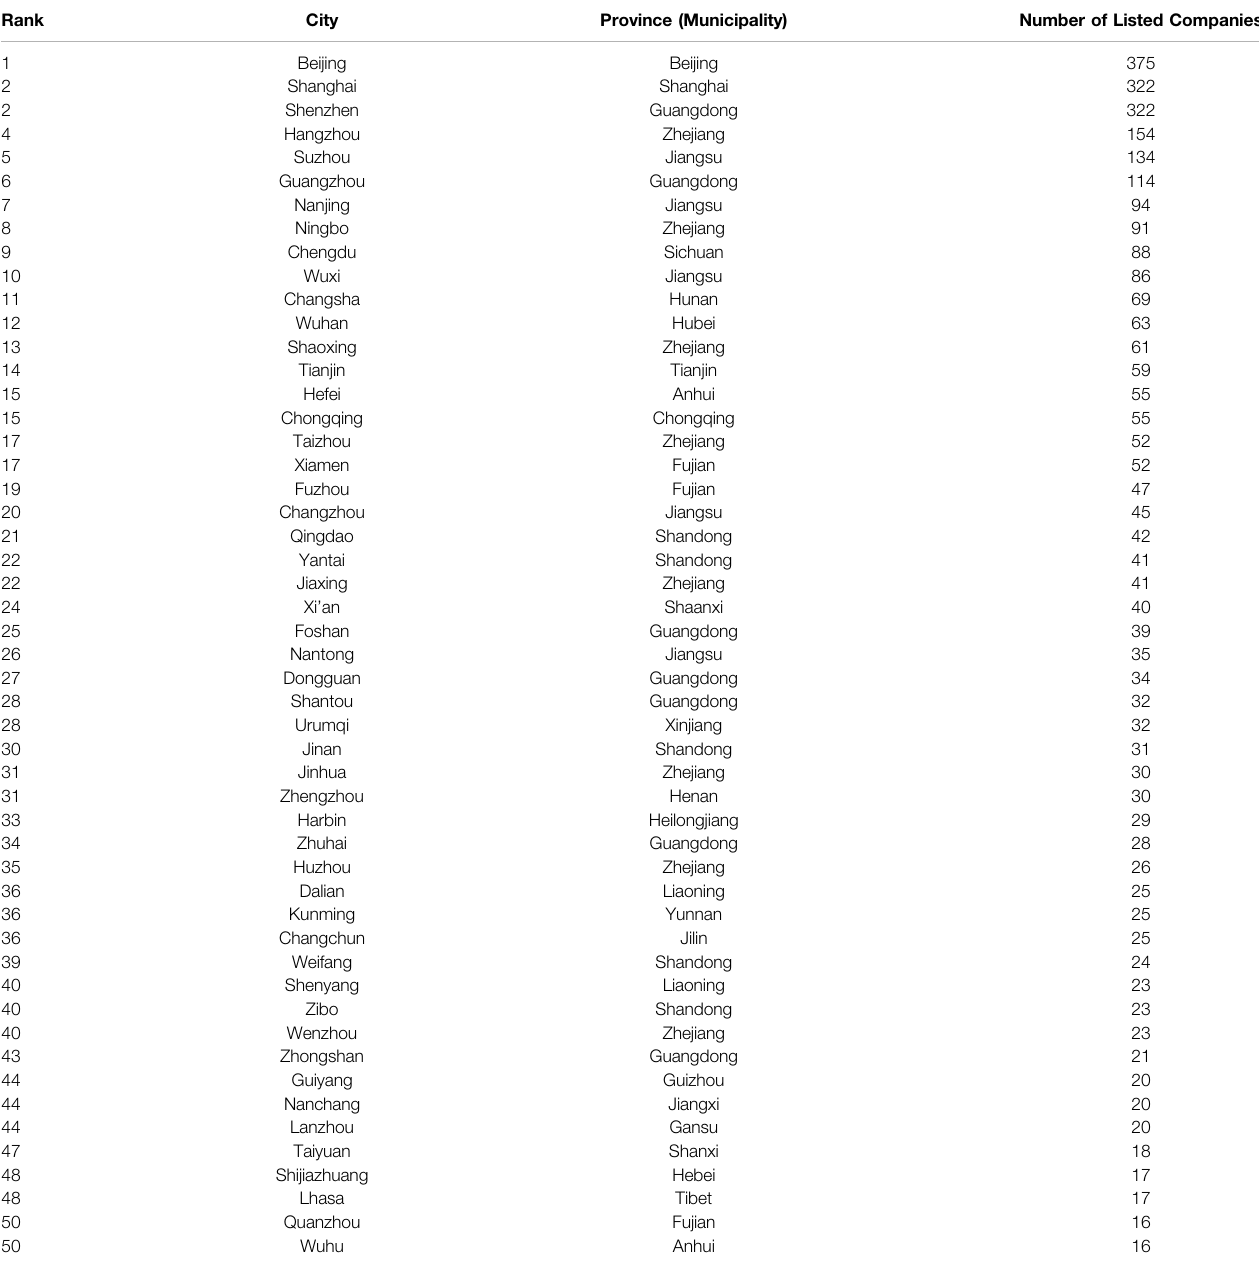
Table 9 | Top 50 cities in terms of number of listed companies